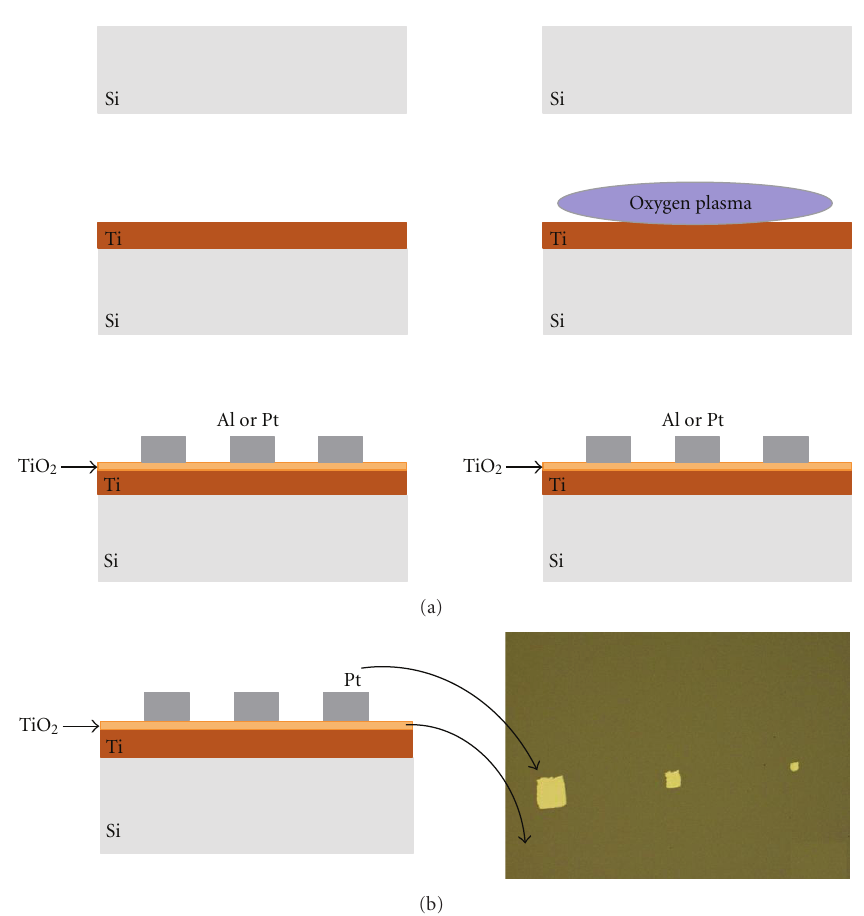
Figure 1: (a) process flow for native oxidized sample (left) and plasma oxidized sample (right). The top electrode was deposited by the shadow mask technique. The squares of sizes 200 microns, 100 microns, and 50 microns were deposited. (b) structure of MIM tunnel diode and its microscopic top view showing the Pt mesas of sizes 200 μ m, 100 μ m, and 50 μ m squares.